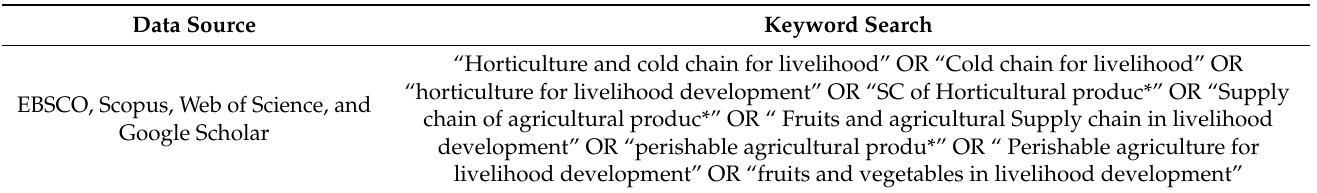
Table 1. Data Source and Keyword Search for data extraction, Source: The Authors.